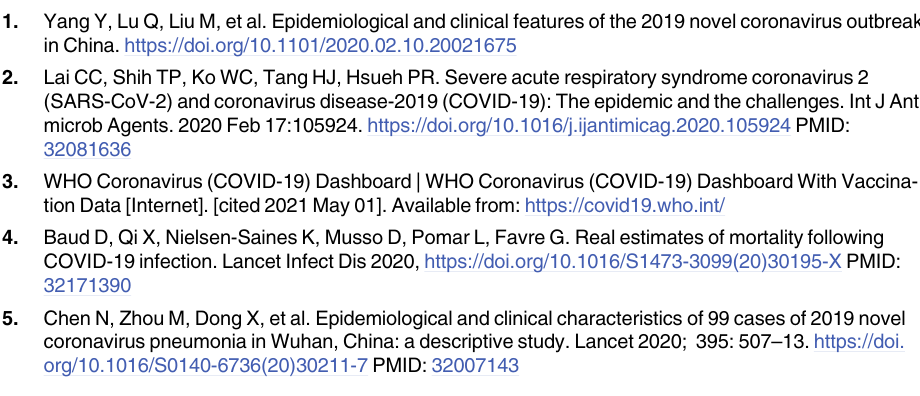
S1 Table. Results of primary outcome after adjustments for